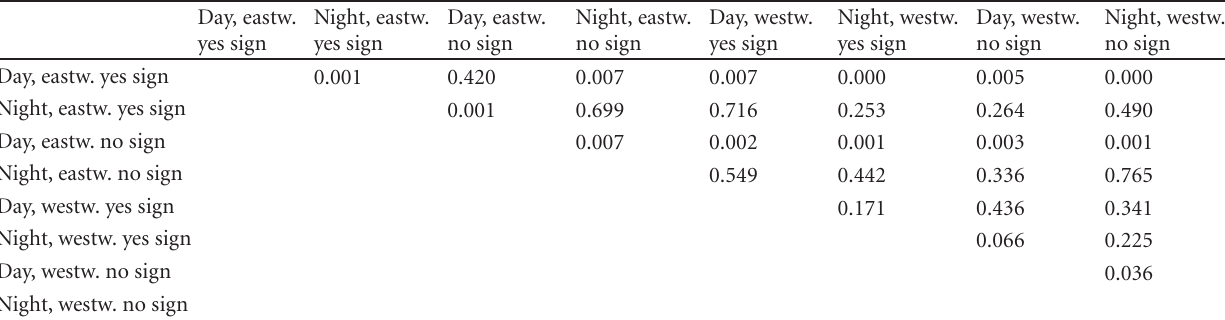
Table 5: MT1 section. Matrix of probability of mutual influence among environmental factors.